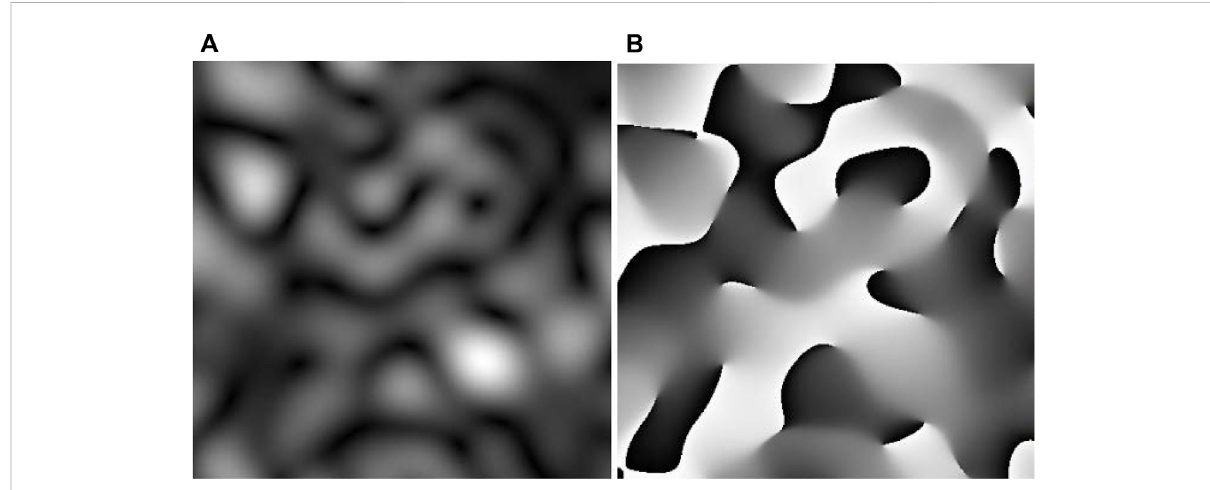
FIGURE 8 Example of the fi eld scattered off a rough surface: (A) intensity distribution, (B) phase distribution.